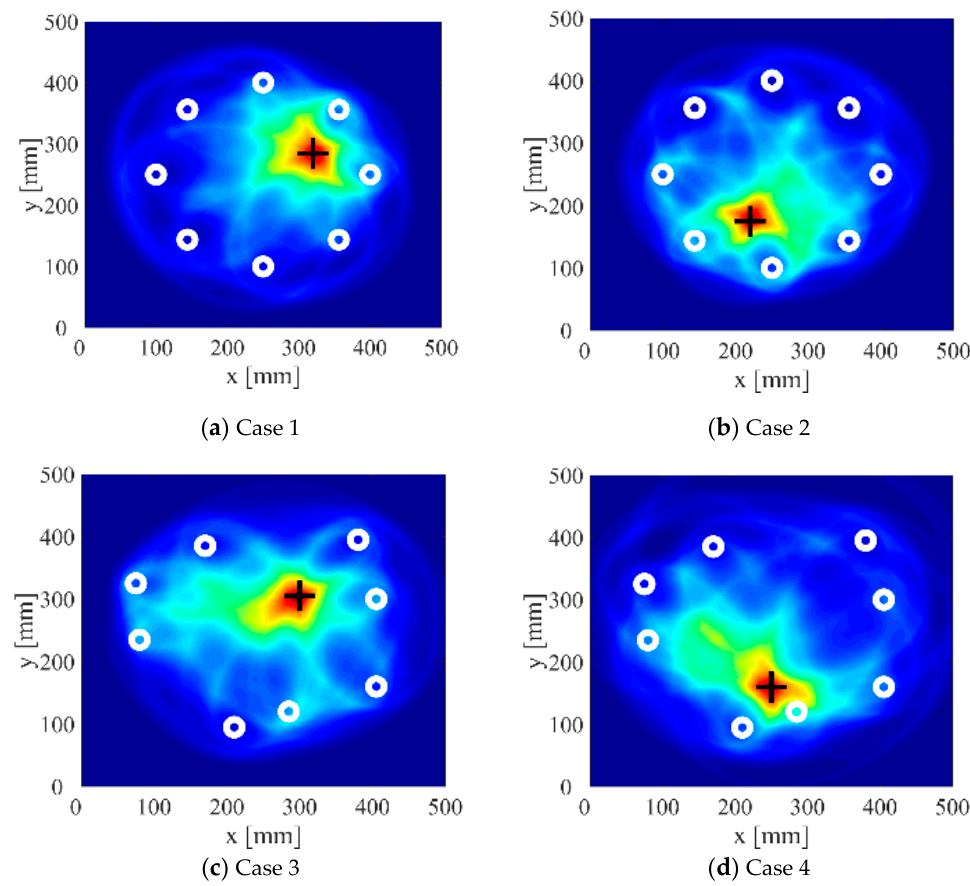
Figure 15. Imaging results with SDC threshold set to 0.02. Table 3. Deviations and aggregation coefficients of localization results of different probabilistic ellipse imaging